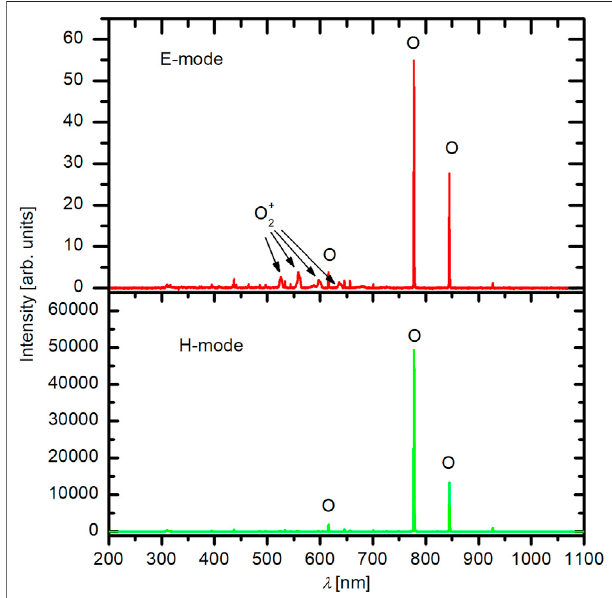
FIGURE 2 | Some spectra of oxygen plasma acquired with a standard optical